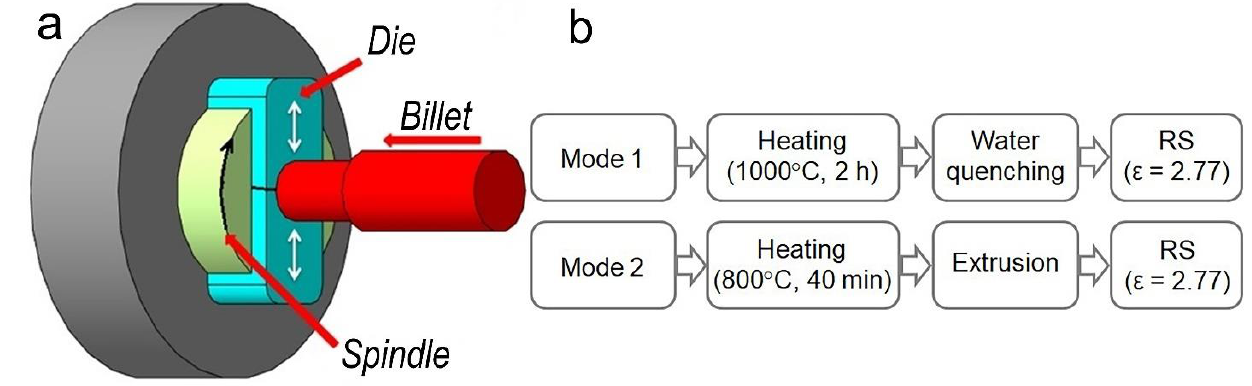
Figure 1. Schematics of the RS process ( a ) and technological modes of alloy processing ( b ).